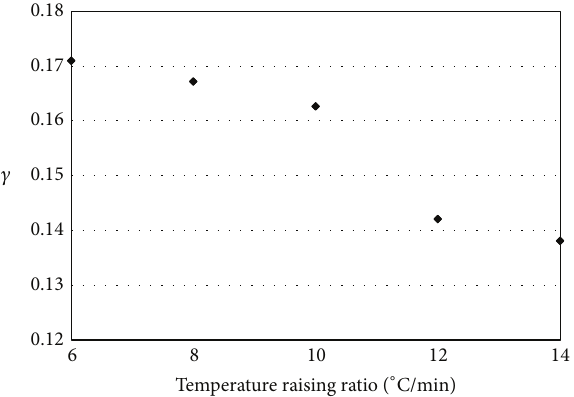
Figure 8: Activity coefficient of produced oil phase at different temperature raising ratios.